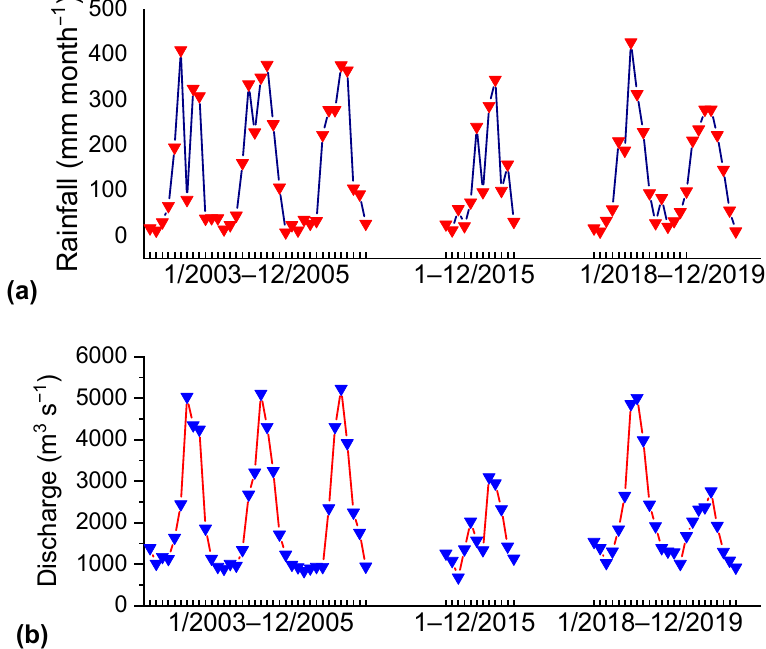
Figure 2. Monthly rainfall in Hanoi ( a ) and Red River’s discharge at the Hanoi hydrological station ( b ).